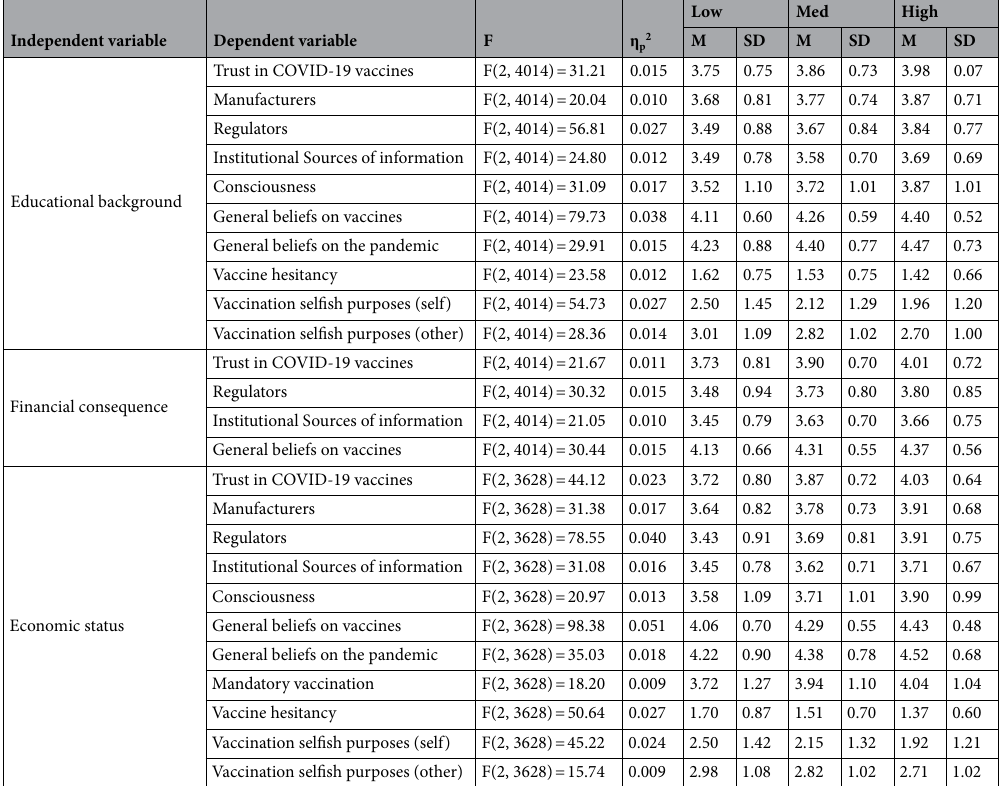
Table 2. ANOVA. This table reported main ANOVA results. All reported results had a p < 0.001 and statistical power was always (1 − β) >